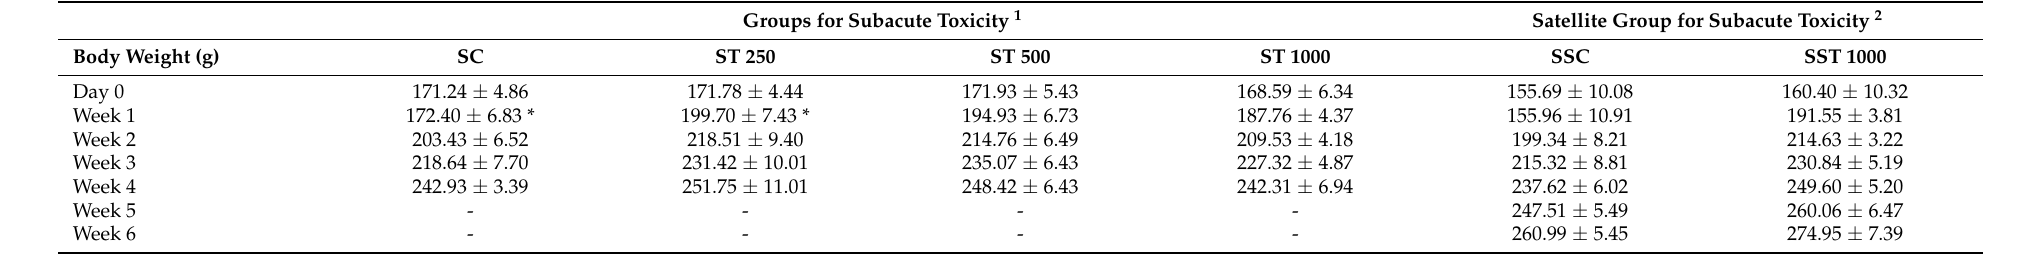
Table 7. Weekly body weight changes for subacute toxicity study. Values are expressed as mean ± SEM. 1 The group administered with E. tapos yoghurt at various dose daily for 28 days in subacute toxicity study. 2 Satellite group for subacute toxicity study, which was given water vehicle or E. tapos yoghurt at 1000 mg/kg daily for 28 days followed by no treatment for 14 days. (*) indicates a significant difference at p < 0.05.